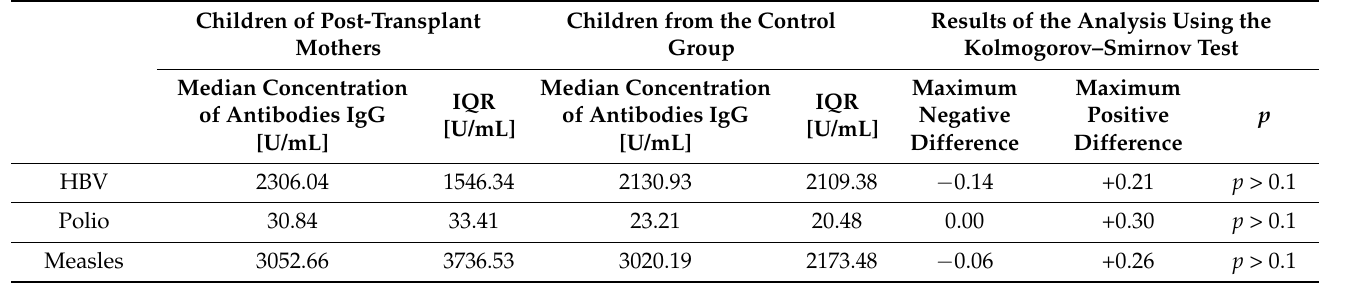
Table 4. Median and IQR ( Interquartile range ) of post-vaccination antibody concentrations (Anti- Poliomyelitis virus 1–3 IgG, Anti-HBsAg IgG, Anti-Measles IgG) in children of post-transplant mothers and in children from the general population.